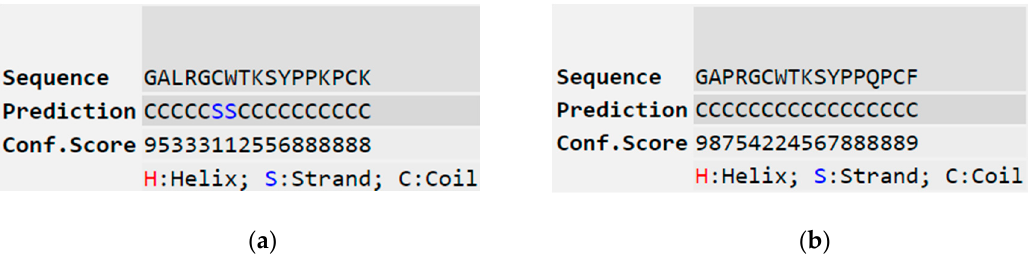
Figure 7. Predicted secondary structures of ranacyclin-T ( a ) and RNF ( b ), obtained from I-TASSER (https://zhanglab.ccmb.med.umich.edu/I-TASSER/) [30]. Table 3. Some parameters of RNF and some reported ranacyclins and their trypsin inhibition Ki values. Amino acid residues at P5 ′ are shaded.